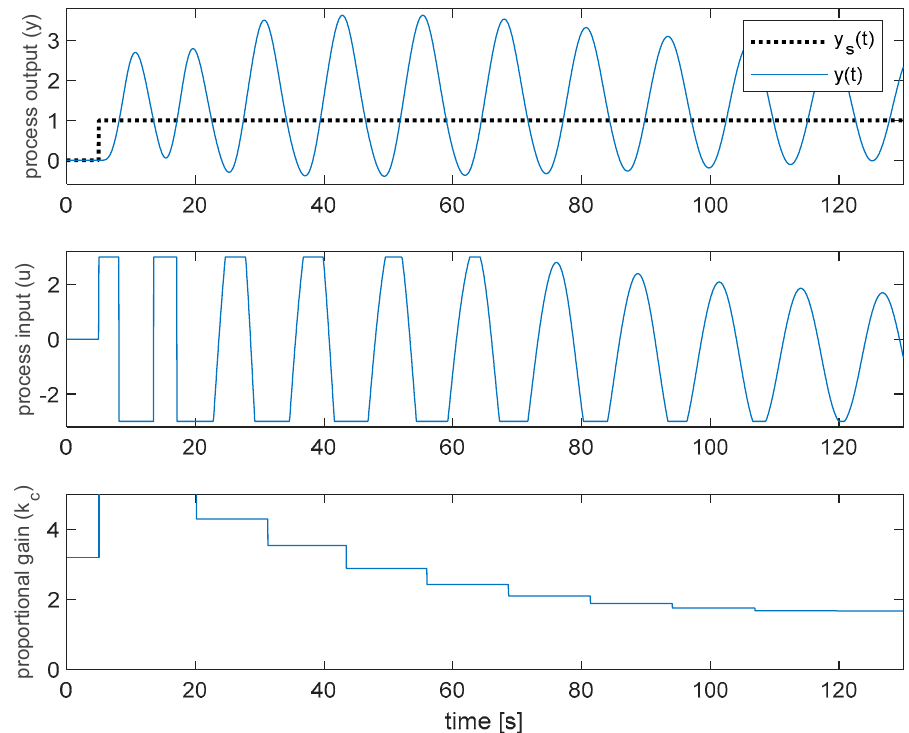
Figure 11. Response of the proposed method combined with the time delay [7] for the high-order plus time-delay process with θ = 0.1 and PA set = − 3 π /4.